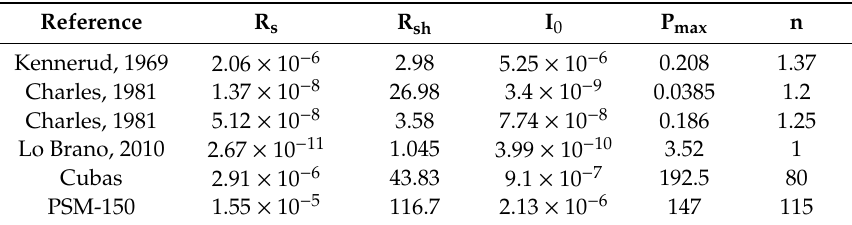
Table A1. 1-Diode / 2-resistors circuit model parameter values from di ff erent solar cells (with data from [41] and by alternative approach).